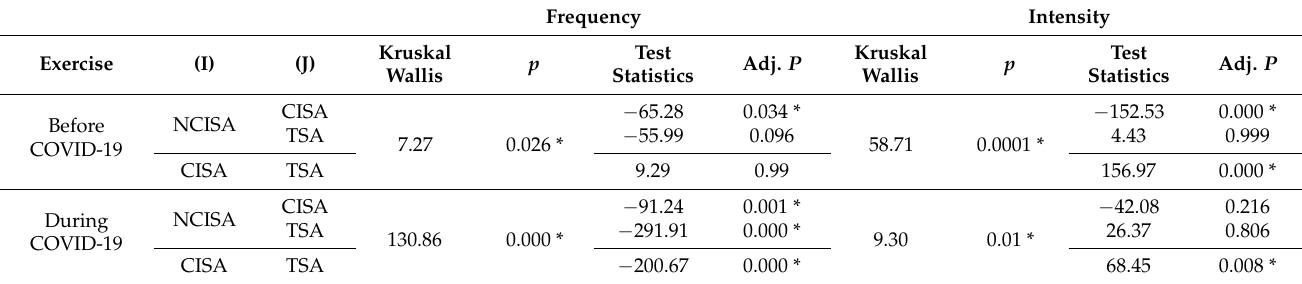
Table 2. Group differences of exercise frequency and intensity before and during COVID-19.